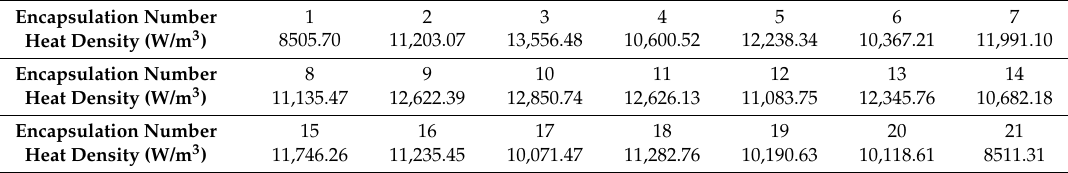
Table 2. Equivalent volume heat density of the encapsulation.